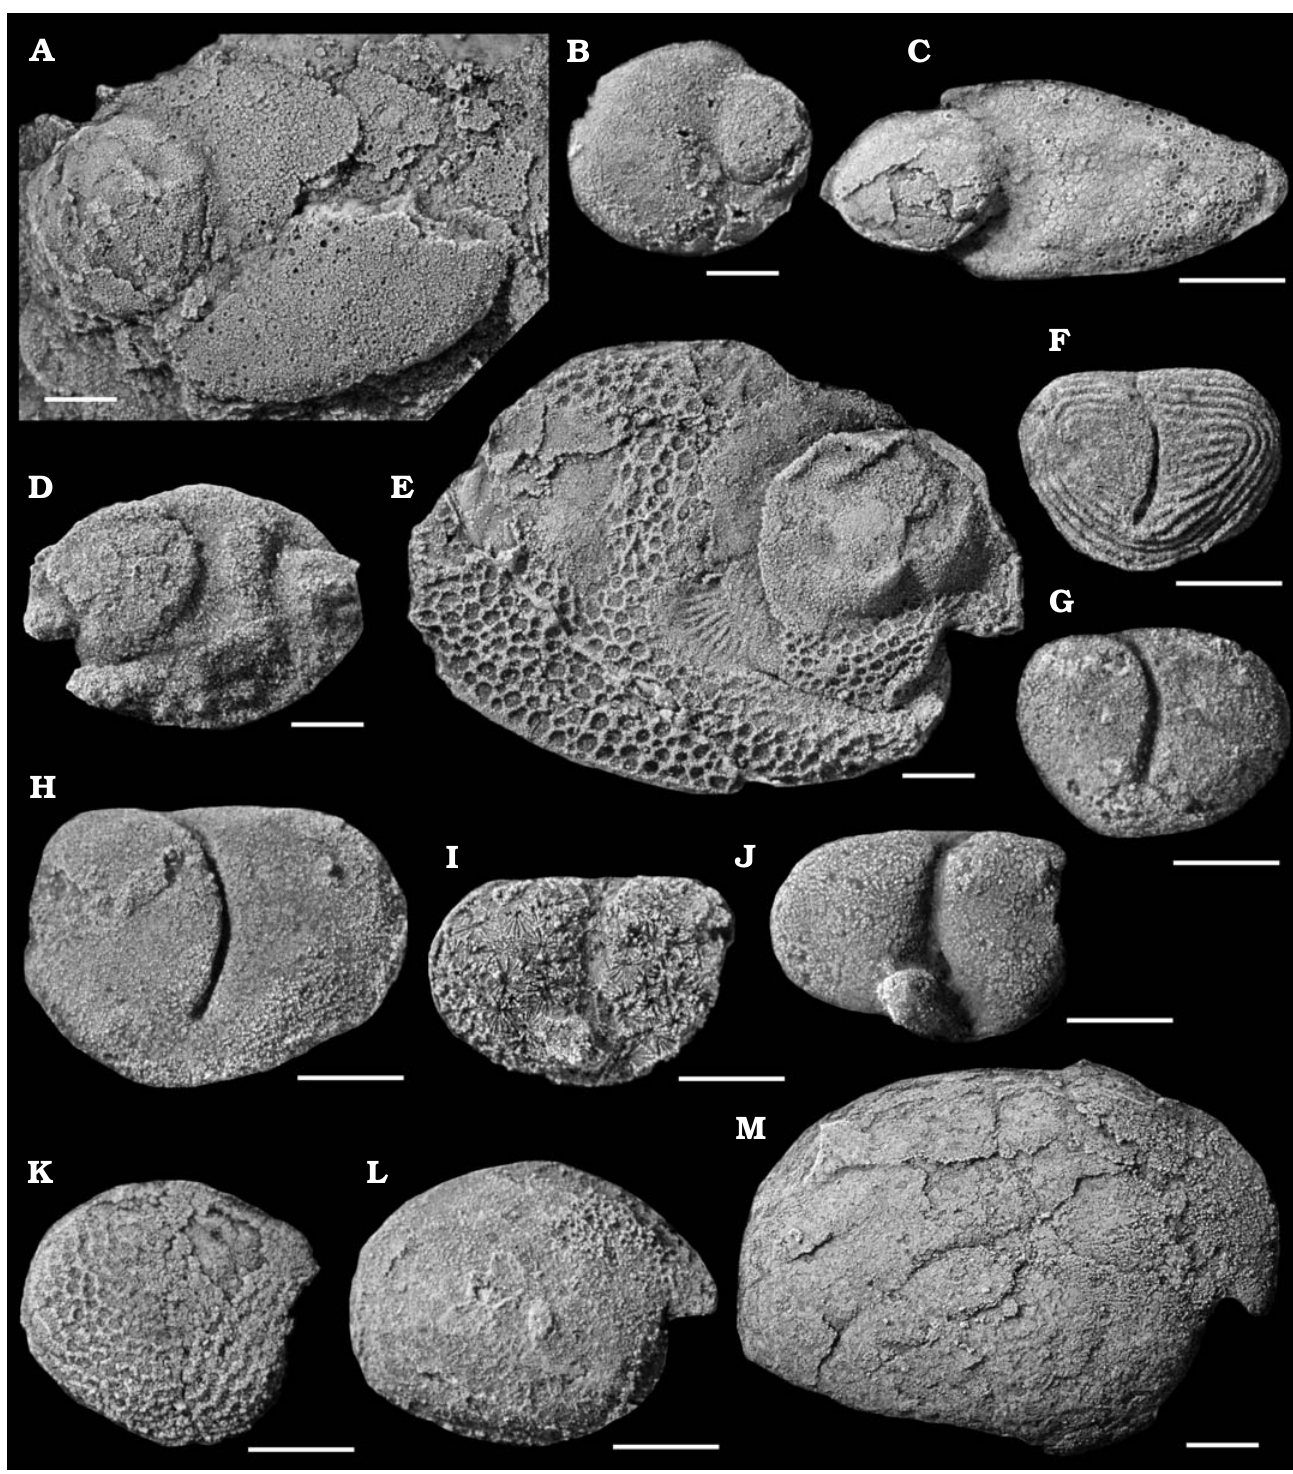
Fig. 2. Selected Silurian myodocope species, Holy Cross Mountains, Poland; Ludlow Series, Silurian. A , B . Bolbozoe anomala Barrande, 1872. A . ZPAL O.63/1, incomplete left valve. B . ZPAL O.63/2, juvenile right valve. C . Bolbozoe psittaca Perrier, Siveter, Williams, and Palmer, 2019, ZPAL O.63/3, left valve. D , E . Parabolbozoe bohemica (Barrande, 1872). D . ZPAL O.63/4, juvenile left valve. E . ZPAL O.63/5, right valve. F . Richteria migrans (Barrande, 1872), ZPAL O.63/6, left valve. G , H . Nudator angiportatus Perrier, Siveter, Williams, and Palmer, 2019. G . ZPAL O.63/7, juvenile left valve. H . ZPAL O.63/8, left valve. I , J . Nudator inflatus Perrier, Siveter, Williams, and Palmer, 2019. I . ZPAL O.63/9, right valve showing post-mortem diagenetic structures. J . ZPAL O.63/9, right valve. K . Silurocypridina retroreticulata Perrier, Vannier, and Siveter, 2011, ZPAL O.63/10, incomplete right valve. L . Silurocypridina calva Perrier, Vannier, and Siveter, 2011, ZPAL O.63/11, right valve. M . Cypridinid?, ZPAL O.63/12, right valve. All light photographs in lateral view. A–H, J, M, silicone casts of external moulds; I, K, L, internal moulds. Scale bars 1 mm, except M 2